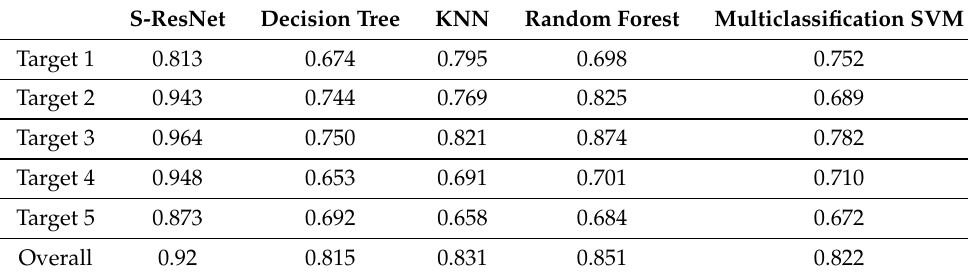
Table 10. Accuracy comparisons of S-ResNet with different algorithms. S-ResNet